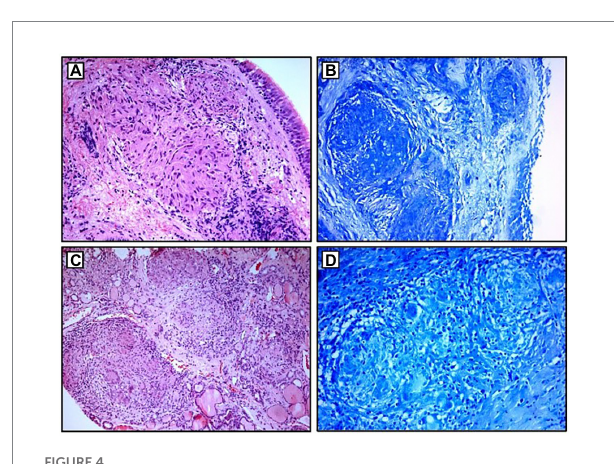
FIGURE 4 Histopathological examination: (A,B) non-necrotizing granulomas in bronchial mucosa and acid-fast stain showing absence of AFB; (C,D) thyroid tissue with non-necrotizing granulomas and acid-fast stain showing the absence of AFB. AFB, acid-fast